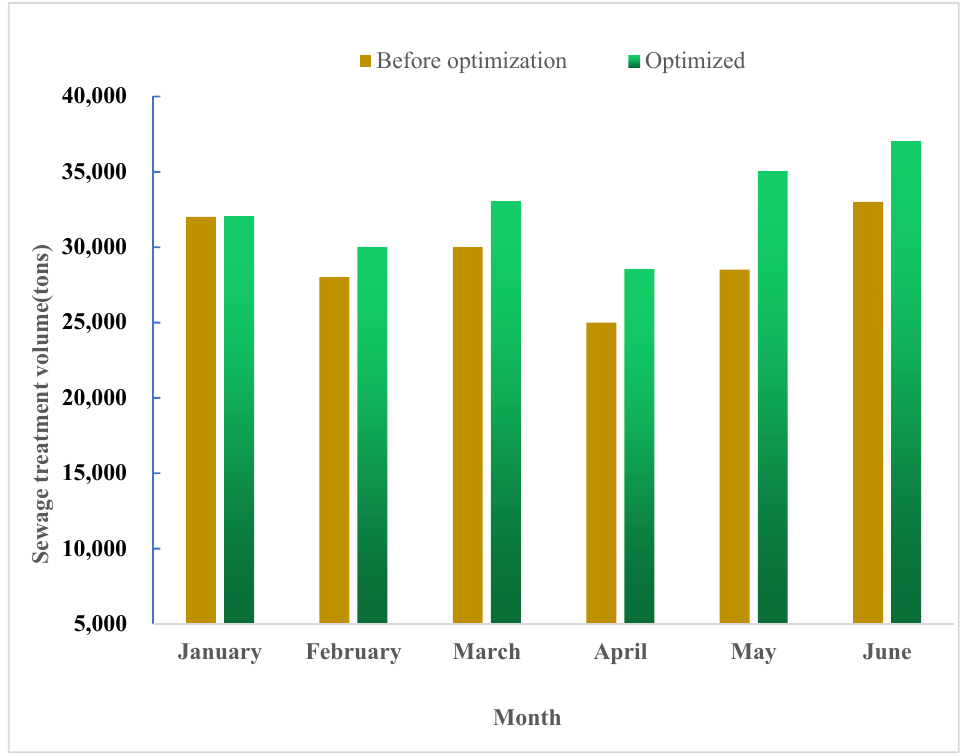
Figure 6. The monthly wastewater treatment volume before and after optimization of the wastewater treatment in Factory A .